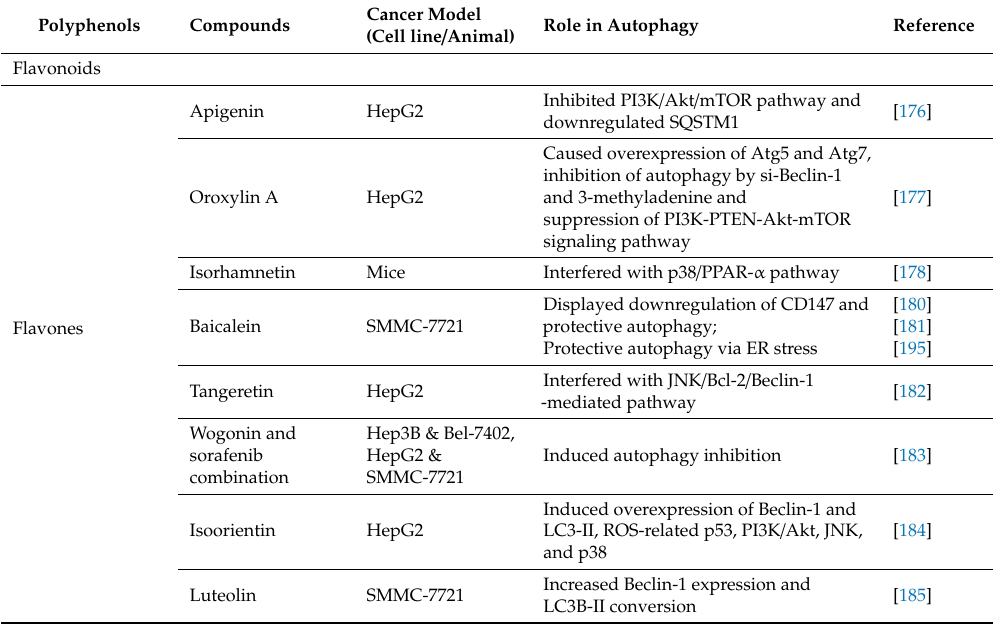
Table 2. Autophagy-associated anti-HCC